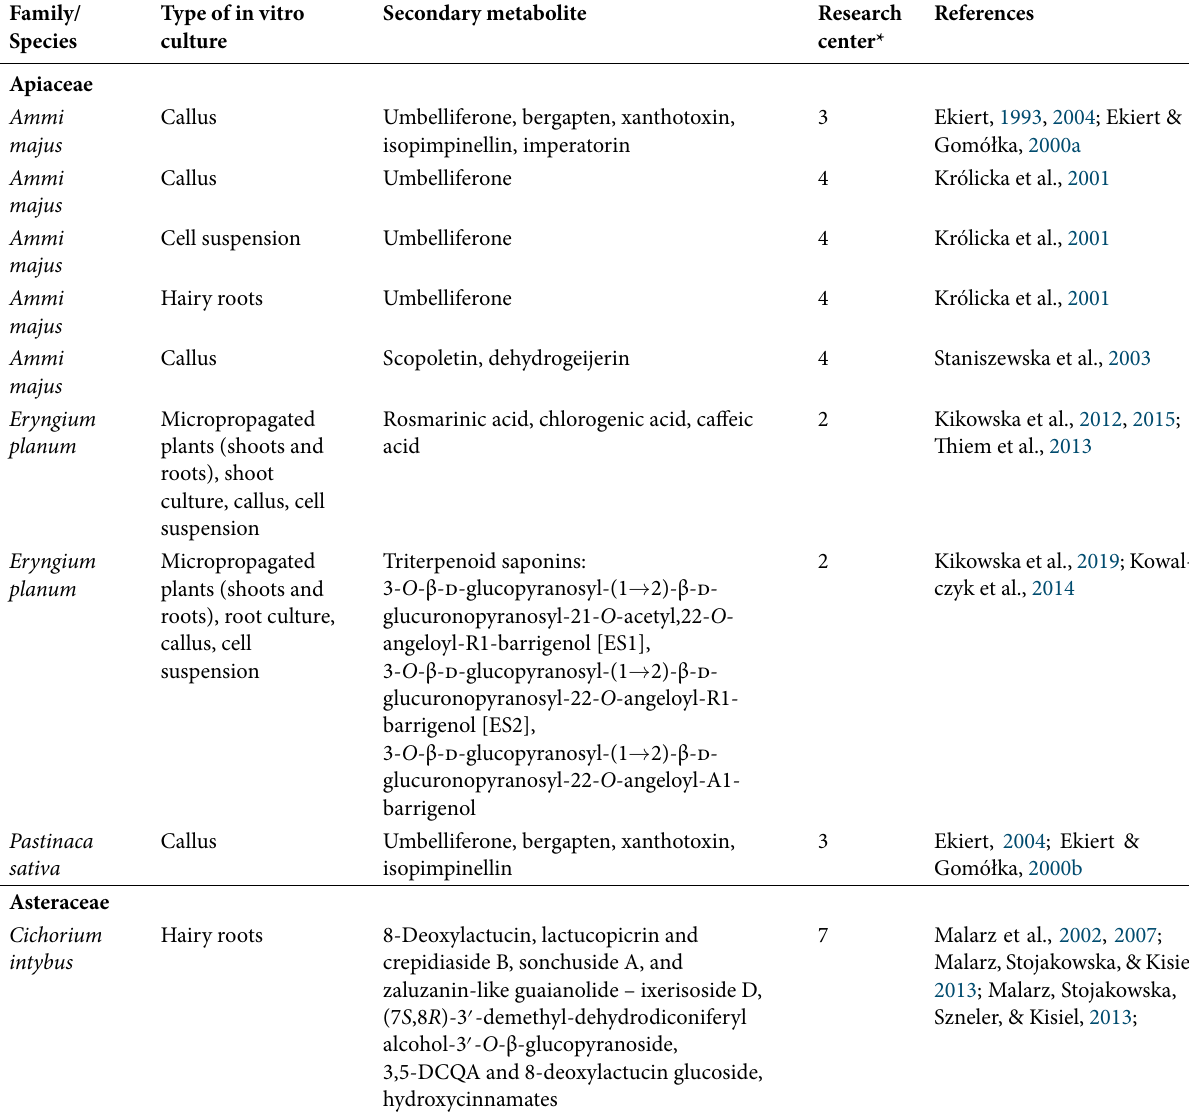
Table 1 Summary of secondary metabolites obtained from various in vitro-cultured plant